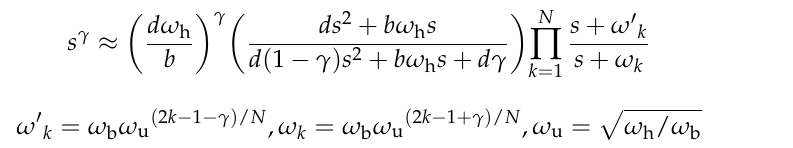
Table 1. Impedance expression of fractional network elements.